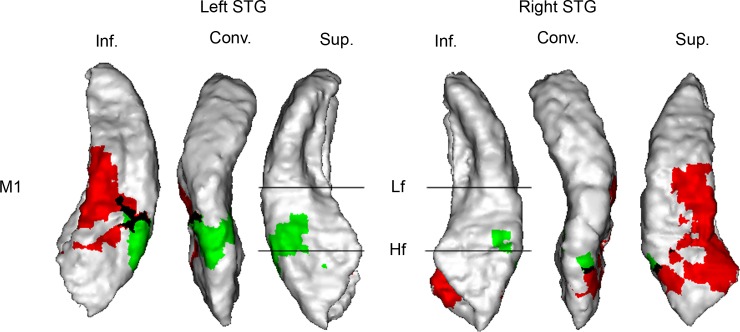
Auditory (in green) and visual (in red) motion-specific areas in monkey 2 (M2).Visual motion-specific areas were identified by the contrast Moving gratings minus Stationary gratings (Experiment 5, t-test: n = 1,241; degrees of freedom [df] = 1,067). Auditory motion data came from Experiment 4, and auditory motion-specific areas were identified by the contrast (Motion minus (Stationary central sound + Spatial laterality + Spectrotemporal effect of motion)) illustrated in Fig 5. The black area corresponds to voxels where both contrasts are significant. Significant statistical results (PFWE < 0.05) are shown on a surface rendering of the superior temporal gyrus (STG) contralateral to the stimuli. Conv., convexity; Hf, high frequency; Inf., inferior bank; Lf, low frequency; Sup., superior bank. See Fig 2 legend for more details. Data are available from the Open Science Framework (https://osf.io/ut5pa/).